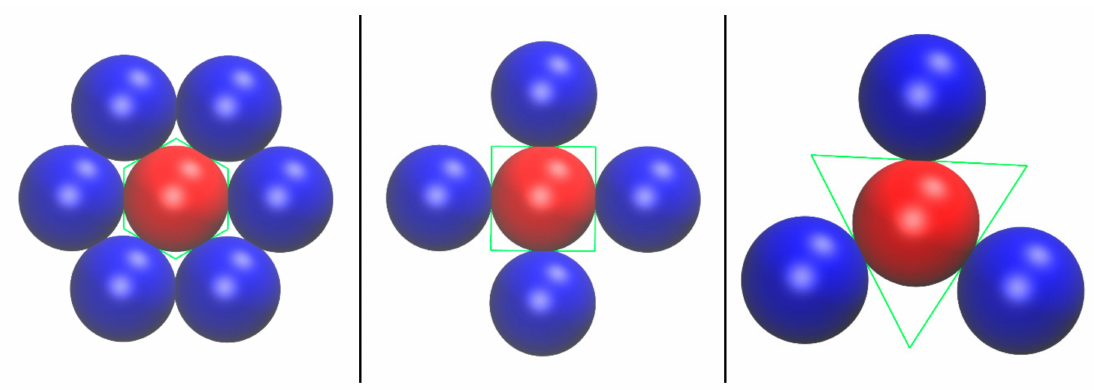
Figure 4. Voronoi polygon and nearest neighbors for 2-D reference crystals. From left to right: TRI, SQU and HON. Voronoi edges are shown as green lines, neighbor sites in blue and reference sphere in red. Image created with the VMD software. Each figure panel is also available as stand-alone image in 3-D, interactive format in the Supplementary